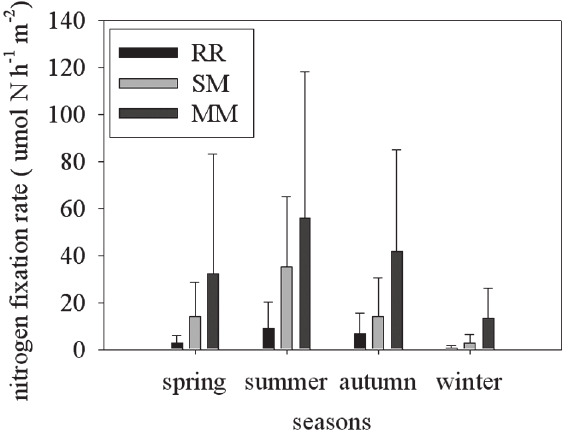
Fig . 5. – seasonal variations in intertidal nitrogen fixation rates (RR: reefs and rocky sediments, sM: seagrass and macroalgae popula- tion, MM: microbial mats) in sanya Bay. C error bars denote standard